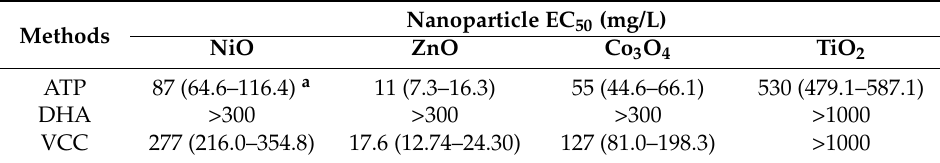
Table 1. Comparisons of NP toxicity on microbial growth on sandy soil (95% confidence level).